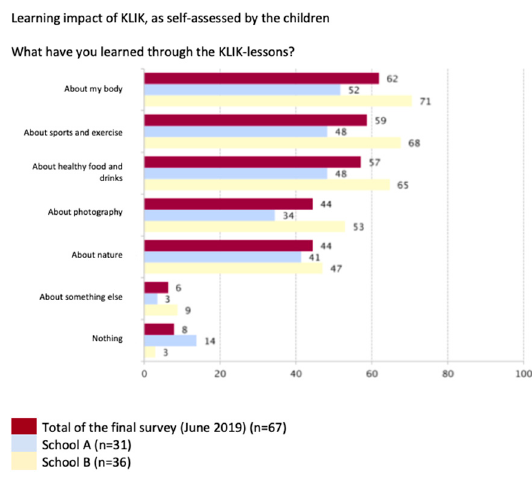
Figure 1. Learning impact of KLIK.